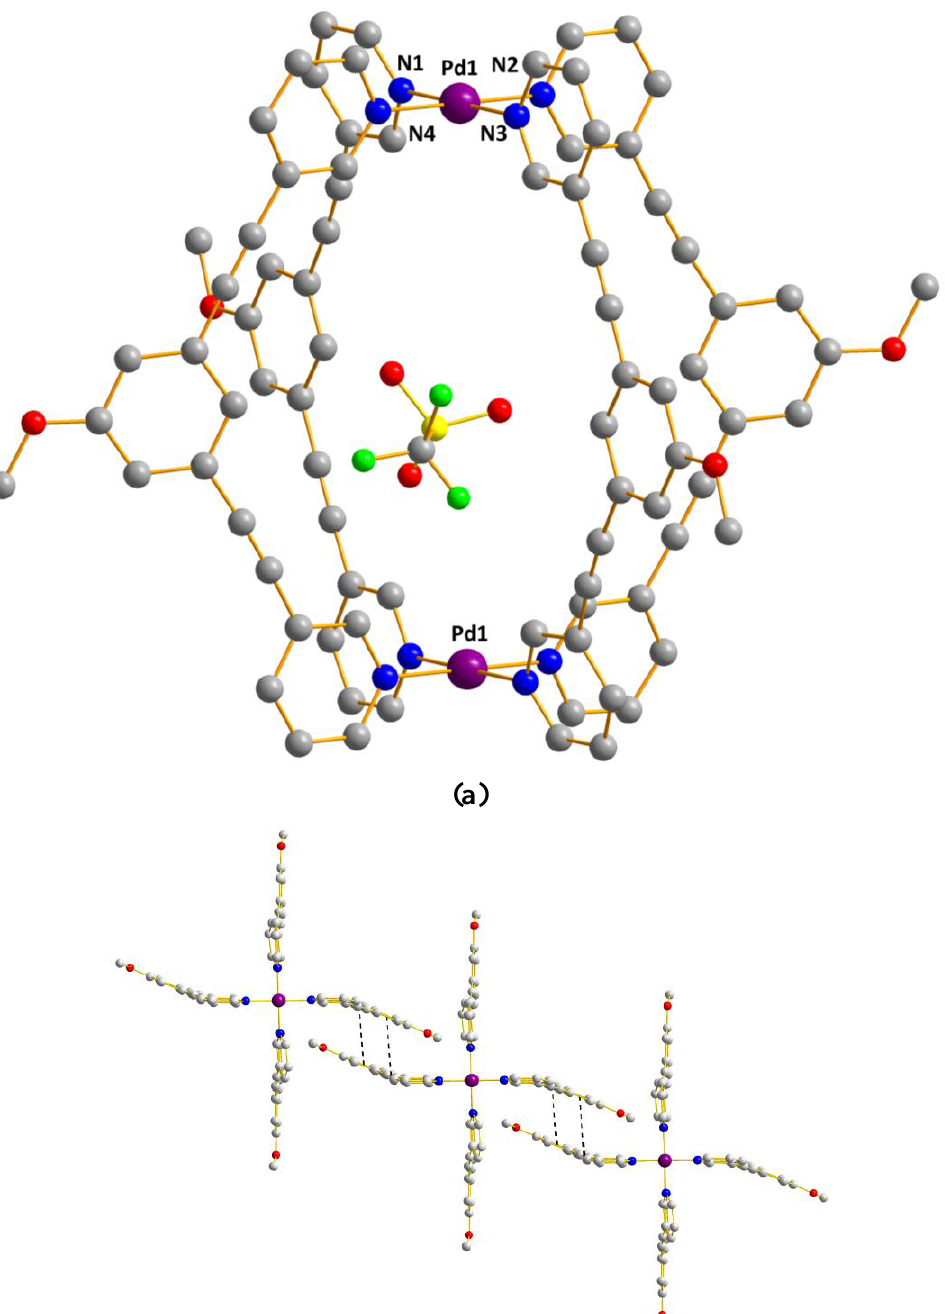
Figure 3. X-ray crystal structure of [Pd with one triflate anion within the cavity. (C gray, O red, N blue, Pd violet; H atoms are omitted for clarity). Selected bond lengths (Å) and angles (°): Pd1–Pd1 11.826 (1), Pd–N1 2.025 (4), Pd1–N2 2.024 (4), Pd1–N3 2.025 (4), Pd1–N4 2.023 (4), N1–Pd1–N3